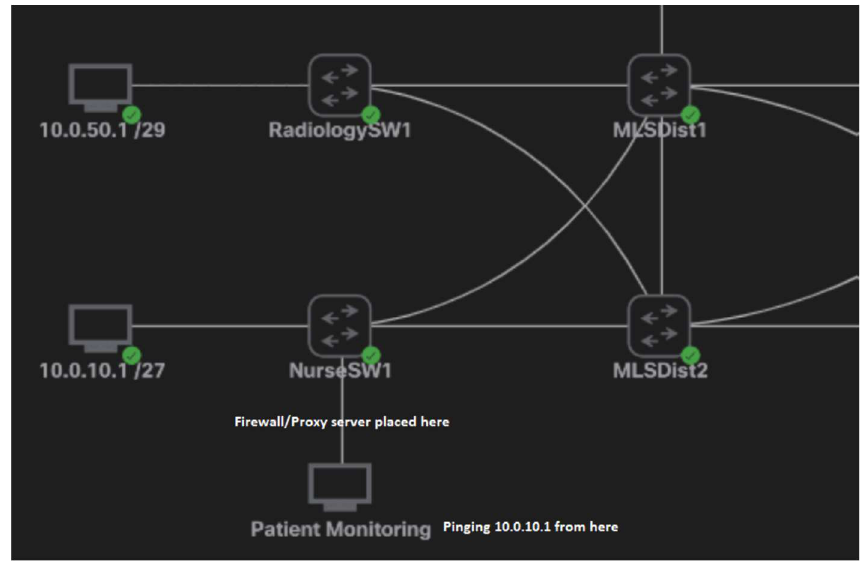
Figure 6. Packet flow and topology for the tests.